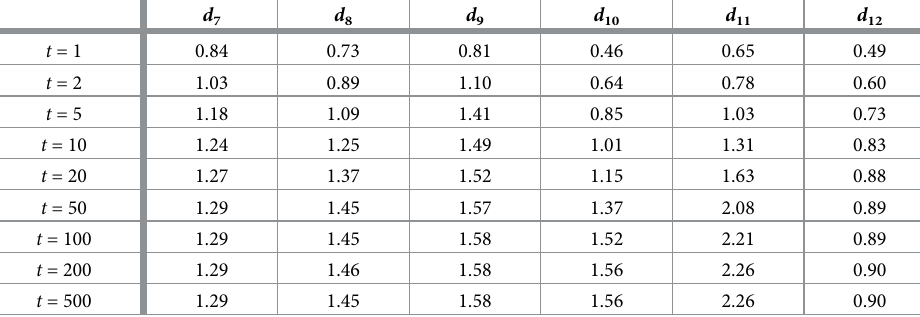
Table 4. The standard deviation of the queue size at time t for dropping functions d 7 − d 12 .